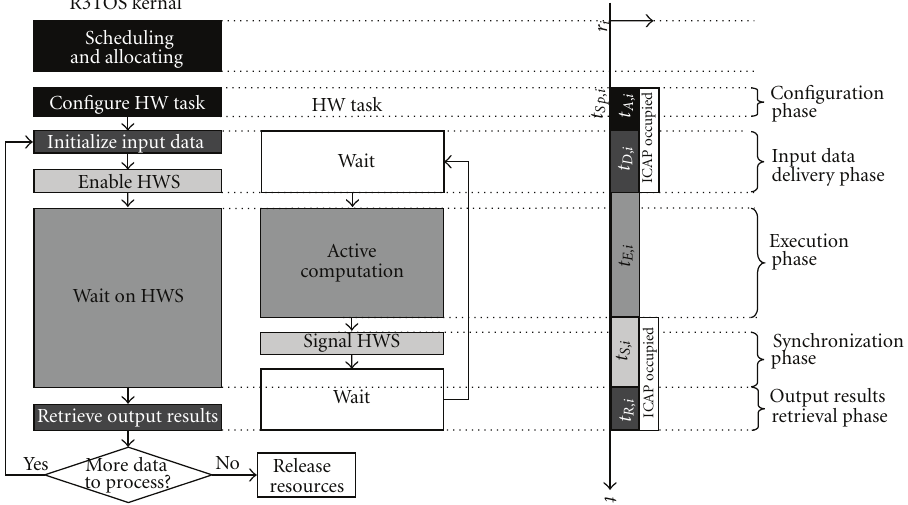
Figure 2: Execution phases of a hardware task in